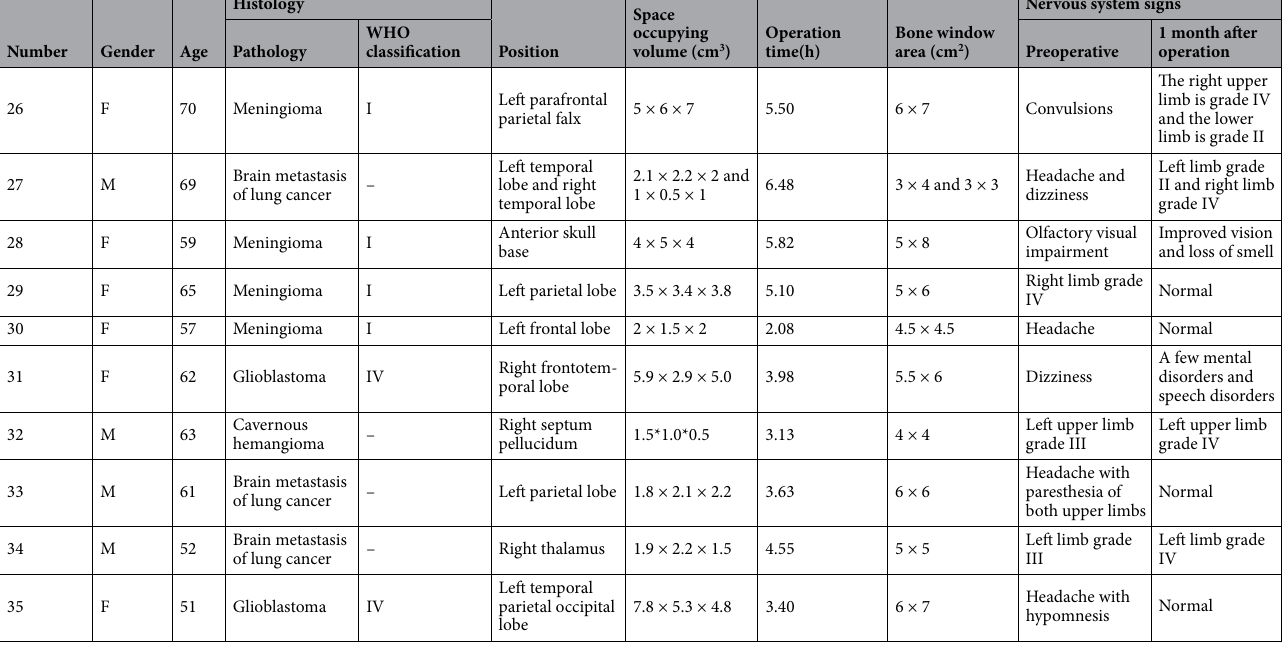
Table 1. The detailed clinical